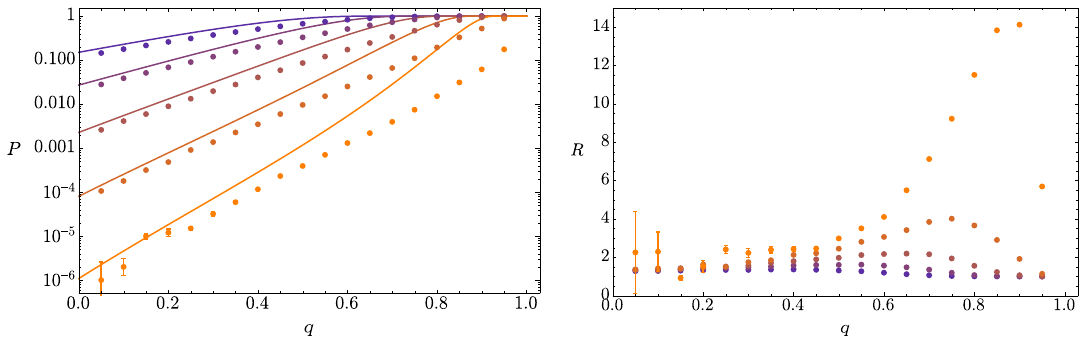
Figure 4 . Left : transition probability as a function of \time" q , starting with a positive de(cid:12)nite matrix and ending in various (cid:12)nal states, see main text for more details. Dots correspond to the Brownian motion result whereas the lines represent the analytical estimate whose validity we are evaluating. Right : ratio between the analytic estimate of the transition probability and the Brownian motion